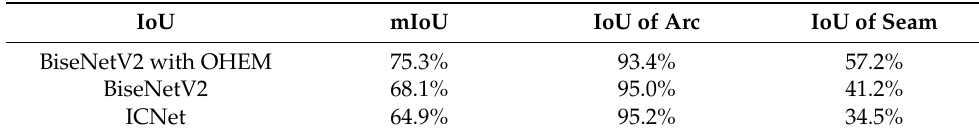
Figure 8. ( a ) Original images and the results for ( b ) BiseNetV2, ( c ) ICNet, ( d ) and BiseNetV2 with OHEM. with OHEM. Table 2. Results of the intersection of